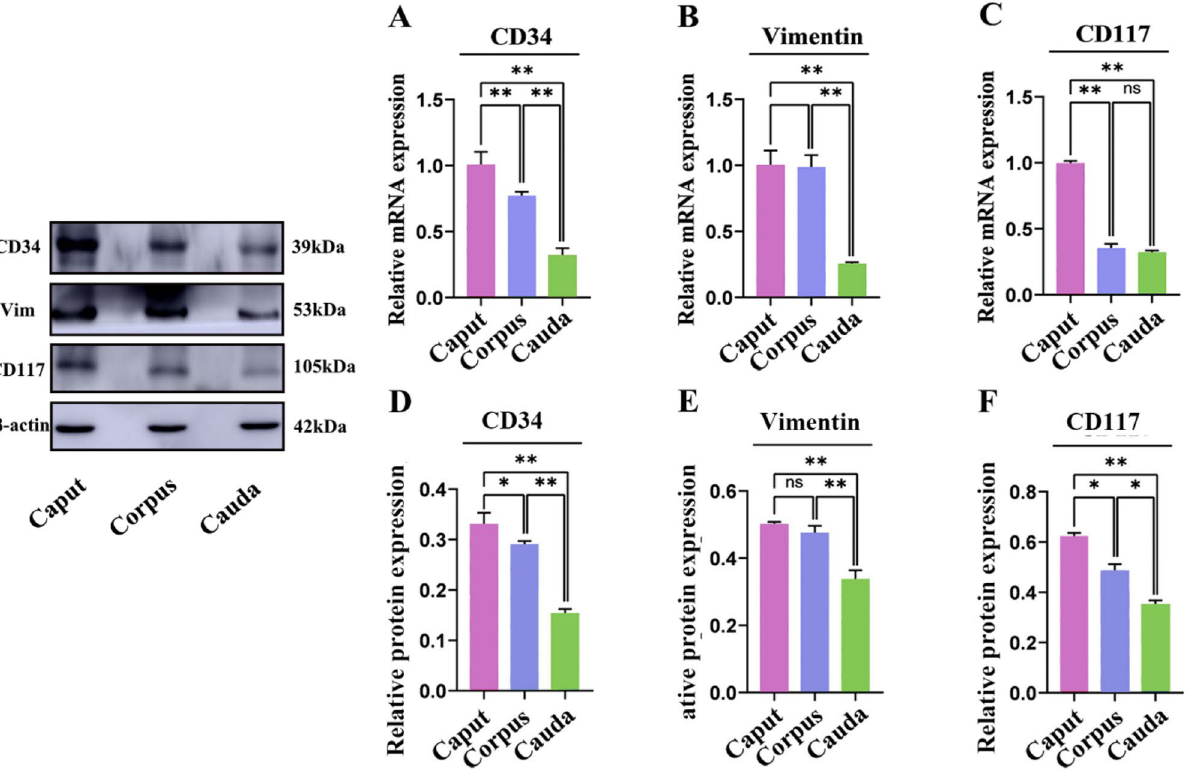
Figure 10. mRNA and protein expression of effective telocyte markers (CD34, vimentin, CD117) in the epididymis of yak. Each sample was tested three times. Results are expressed as the mean ± standard deviation, with β-actin gene and protein expression used as an internal control. ** p < 0.01; * p < 0.05; NS (not significant), p >